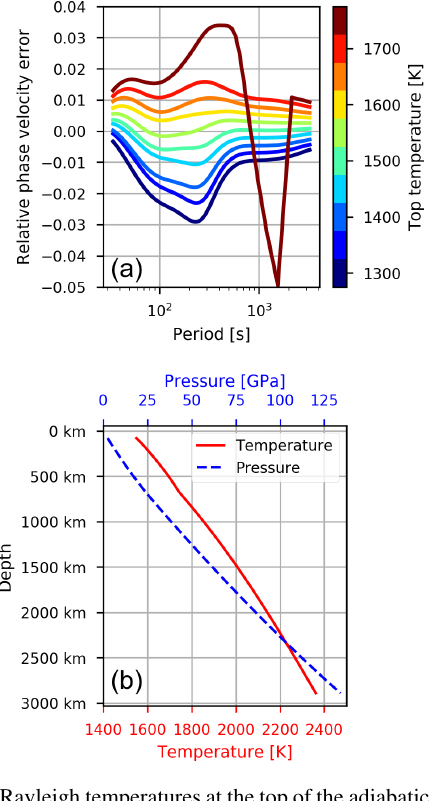
Figure A1. Results of the adiabatic model. (a) Rayleigh temperatures at the top of the adiabatic model (80km). (b) Temperature and pressure profiles for the preferred model with T top = 1550K.